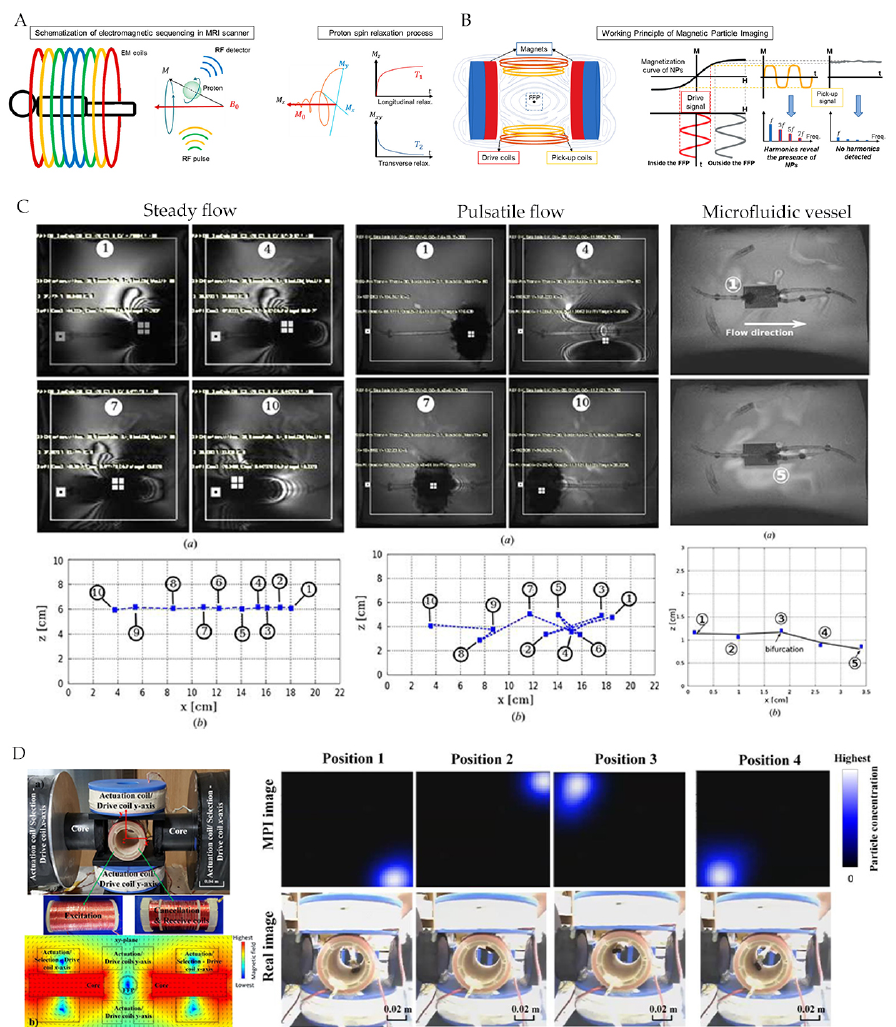
Figure 7. ( A , B ) are the working principles of MRI and MPI, respectively. Adapted with permission from [20]. Copyright 2020 American Chemical Society. ( C ) Localization based on magnetization artifacts in MRI images. Reproduced with permission from [66]; published by Taylor & Francis, 2016. ( D ) 2D MPI localizing. Reproduced with permission from [70]; published by MDPI,